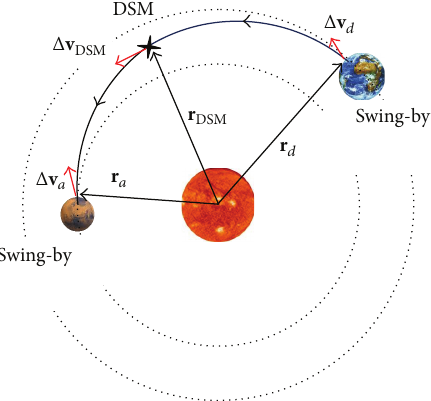
Figure 1: Three-impulse transfer